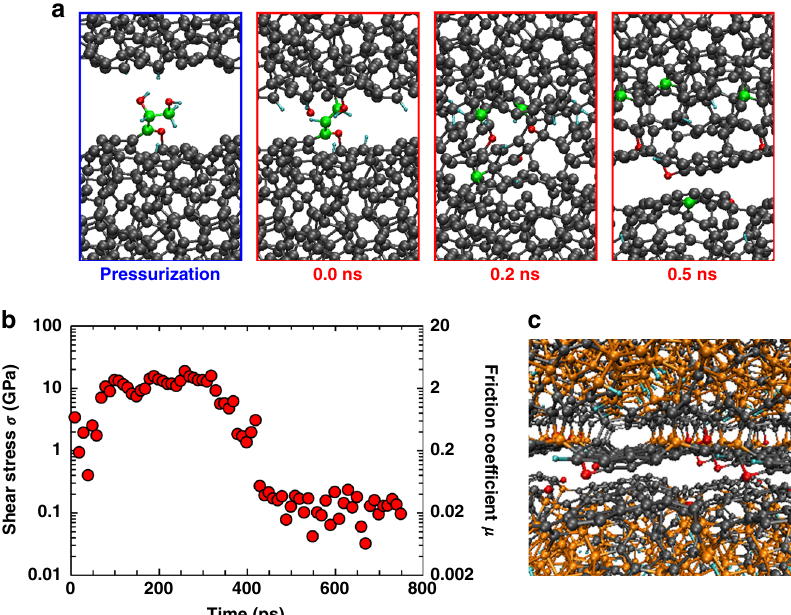
Fig. 5 A QMD simulation of two ta-C surfaces lubricated with a glycerol molecule. a Snapshots of the 1-ns sliding simulation. b Evolution of the shear stress σ and friction coef fi cient μ . c Shear-induced aromatic passivation of both ta-C surfaces. 3- and 4-fold coordinated C atoms are represented in grey and orange spheres,